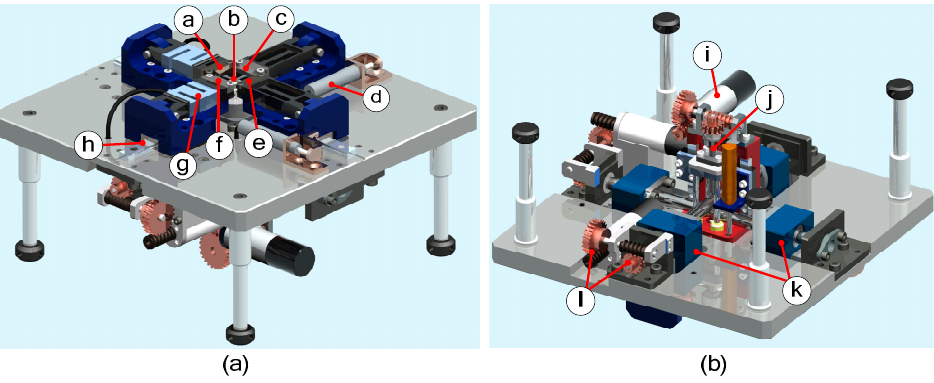
Figure 1. Mechanical properties of the biaxial tensile-bending composite test apparatus. ( a ) The top of the apparatus structure; ( b ) The bottom of the apparatus structure. ○ a Clamp D; ○ b Specimen; ○ c Clamp A; ○ d Displacement sensor; ○ e Clamp C; ○ f Clamp B; ○ g Force sensor; ○ h Guide rail; ○ i Servo motor; ○ j Bending ball screw; ○ k Two-way ball screw; ○ l Worm gear reducer.